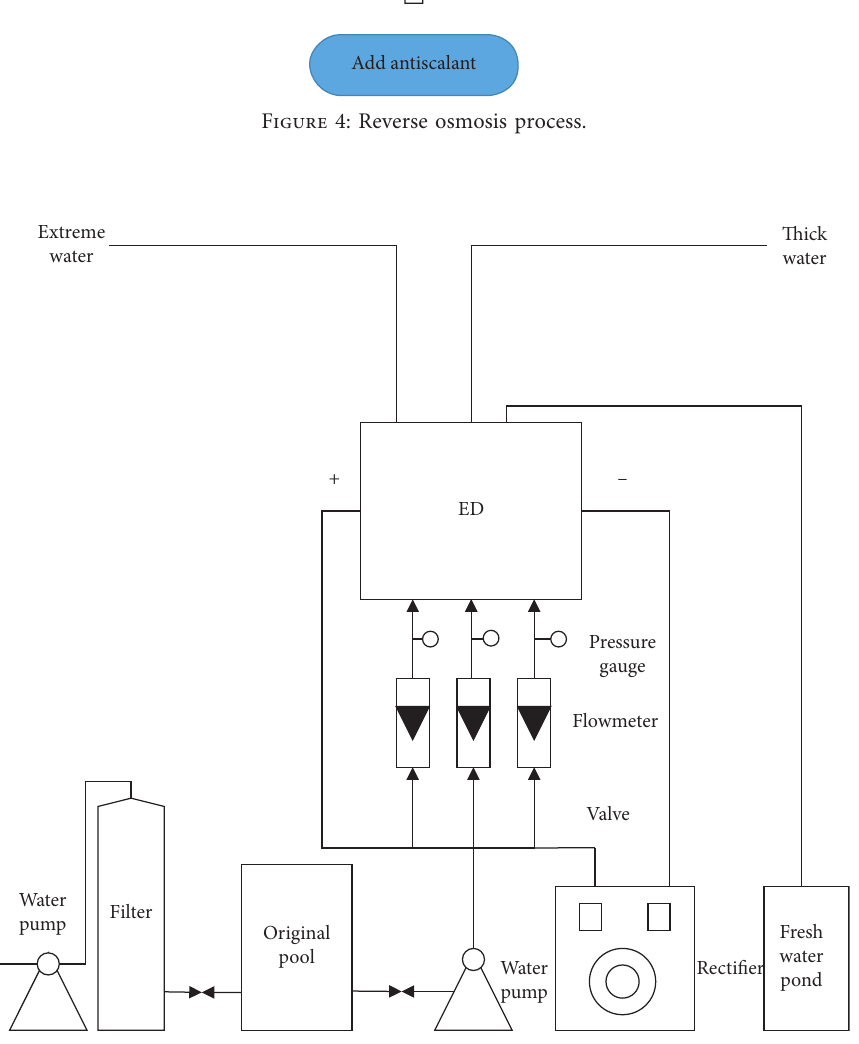
Figure 5: Process flow diagram of electrodialysis